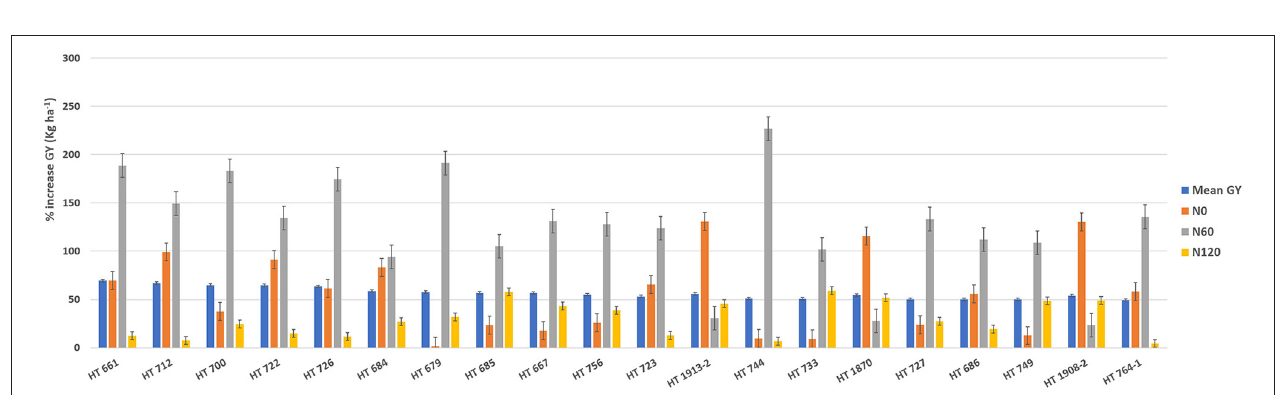
FIGURE 7 | The GGE biplot showing the performance of 352 nested synthetic wheat introgression lines across seasons and treatments (N0, N60, and N120). The environment view refers to the three different levels of nitrogen (N) application: N0, N60, and N120. The genotype view refers to the 352 nested synthetic wheat introgression lines. The numeric number refers to the coding for the introgression lines, which is given in detail in the Supplementary Table 7 .